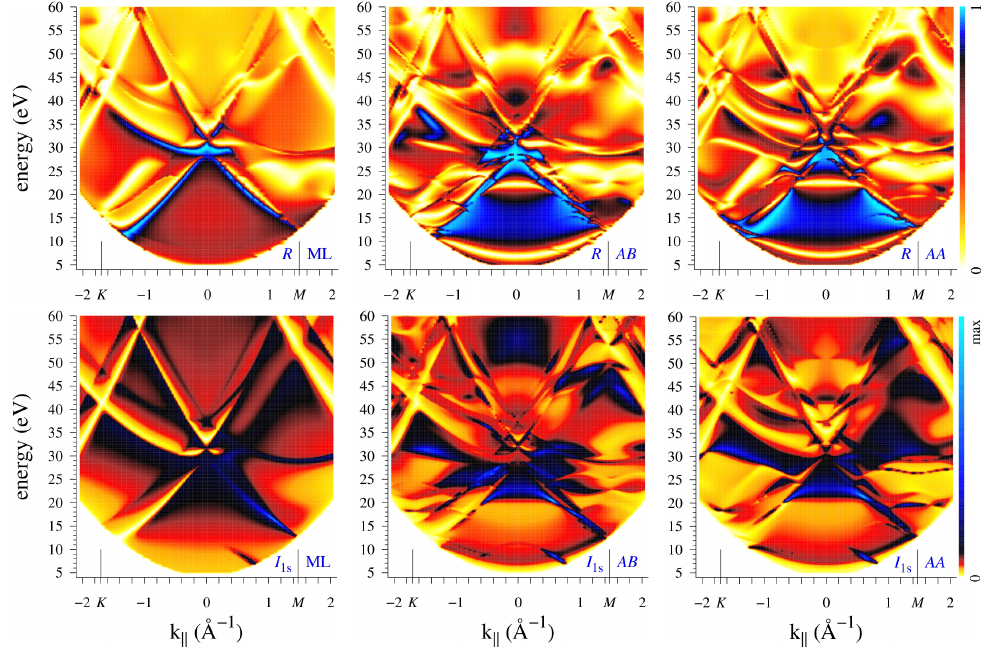
Figure 6. Energy–momentum distribution of reflectivity ( upper row ) and C 1 s photoemission ( lower row ) for graphene monolayer and bilayers of AB and AA stacking, 1st, 2nd, and 3rd columns, respectively. Shown are Γ K (negative k || ) and Γ M (positive k || )